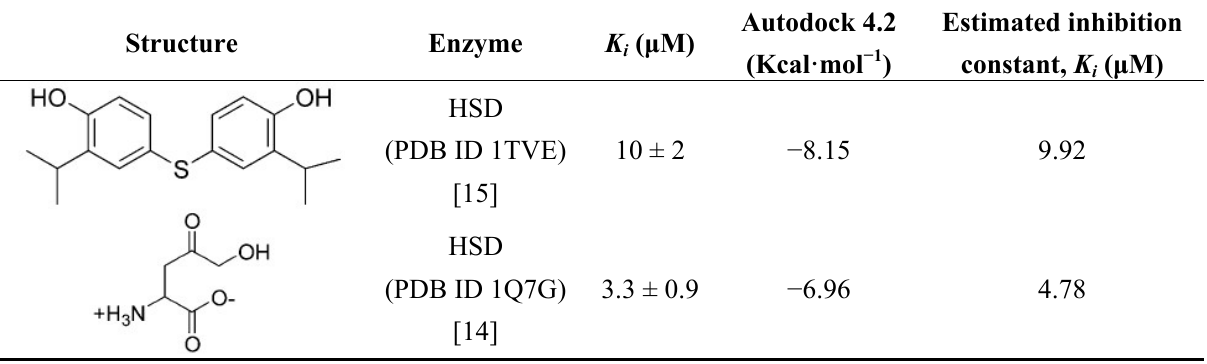
Table 4. Discovered ligands from the docking screen against the known crystal structure.